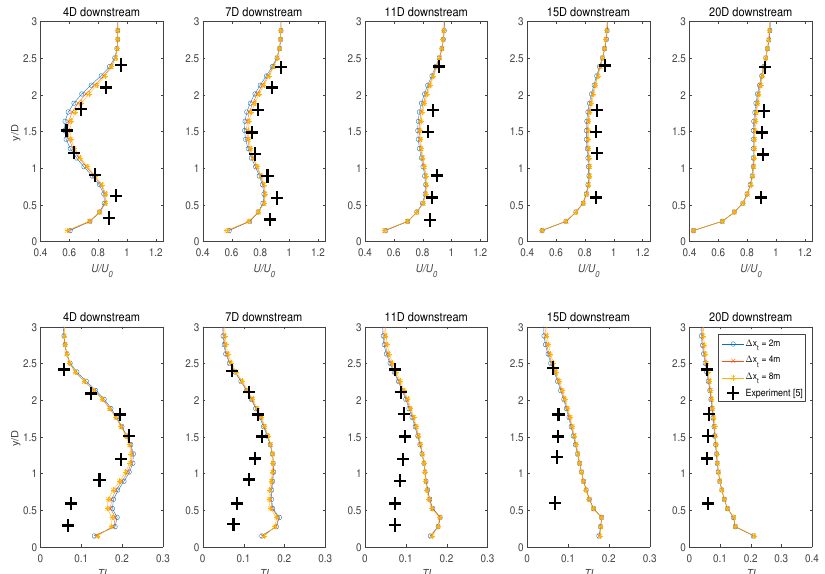
Figure 6. The influence of the disc thickness, ∆ x t on the flow at increasing distances downstream of the turbine. The value of ∆ x t was varied, while the vertical resolution ∆ z and the size of the structured grid ( ∆ x & ∆ y ) were maintained at 24 sigma layers and 2 m, respectively for all cases.